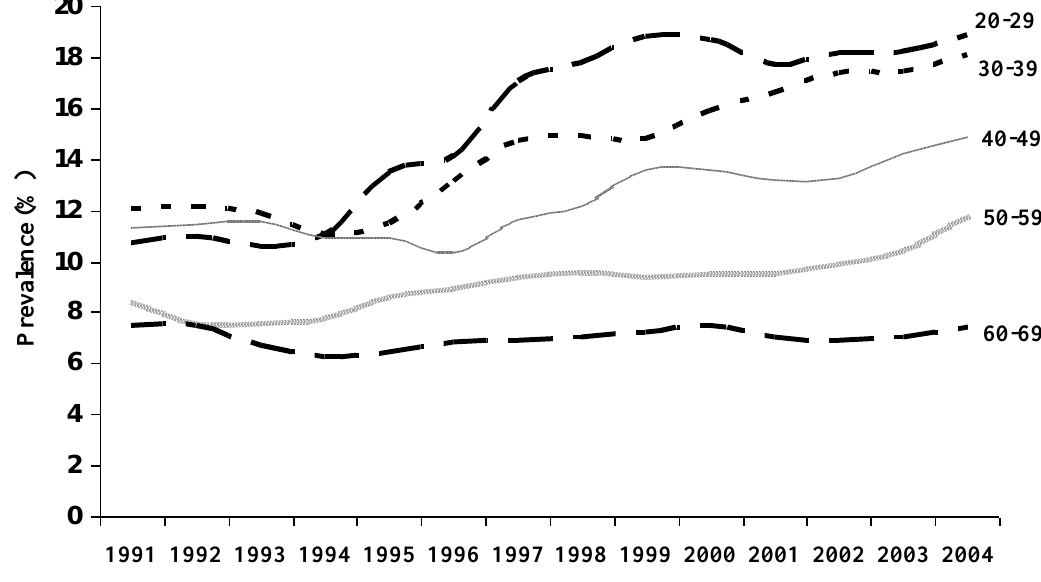
Figure 4. Japanese female smoking prevalence—Three year moving average of female Japanese smoking prevalence using 10-year age